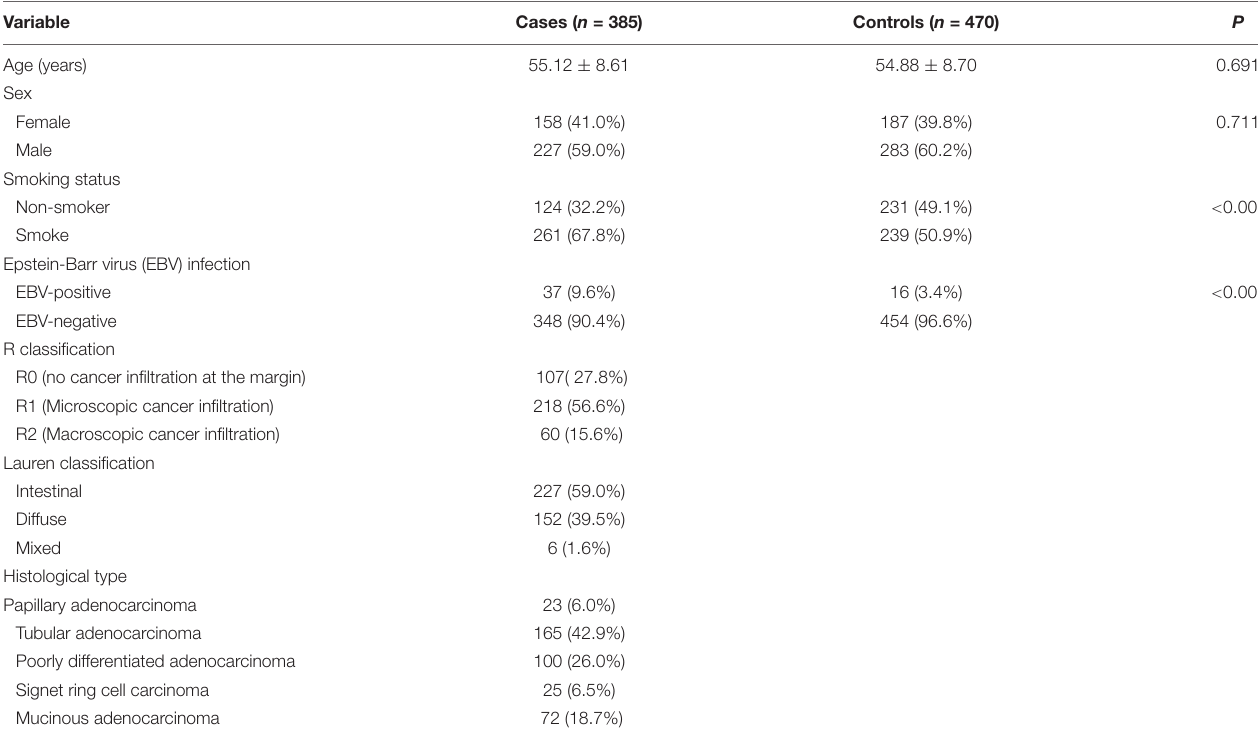
TABLE 1 | Patient demographics and risk factors in gastric